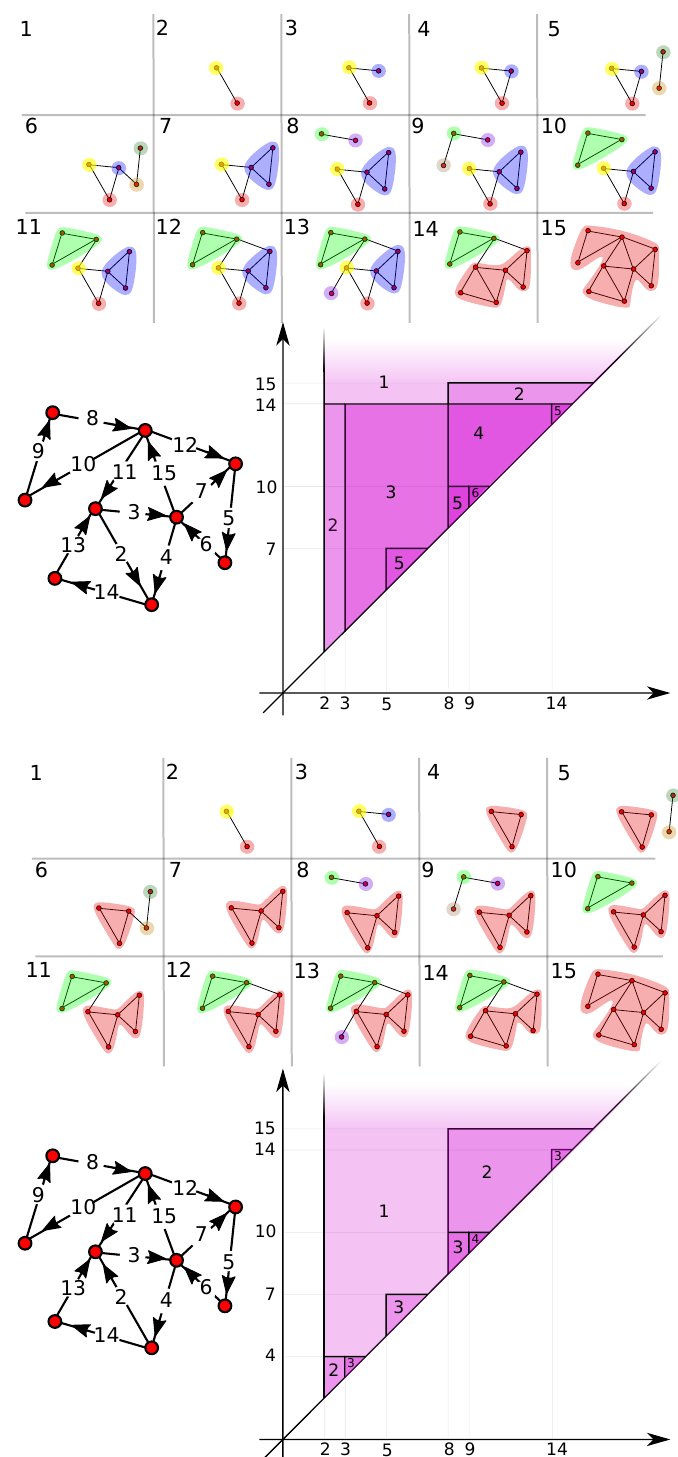
Figure 8. Two orientations of the weighted graph of Figure 1, differing by the orientation of the edge with weight 2. For each, the weighted digraph (left), the corresponding filtration (above) and its persistent strong component number